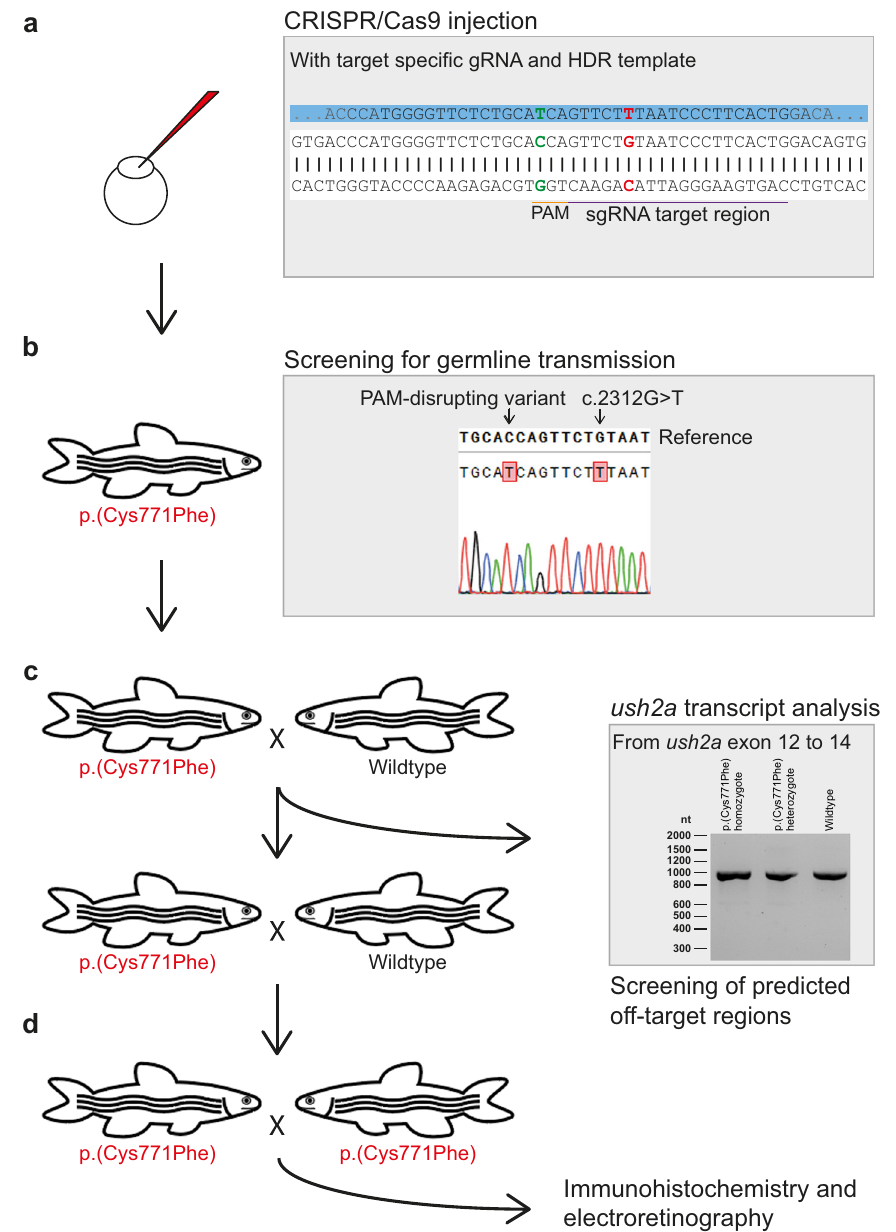
Fig. 2 Generation of the usherin p.(Cys771Phe) zebra fi sh model. a Eggs were injected at a one-cell stage with CRISPR/Cas9 mix containing both the target speci fi c single guide RNA (sgRNA) and the 126 nt homology directed repair (HDR) template (partially depicted, in blue) for incorporation of the c.2312 G > T (p.(Cys771Phe)) variant (in red) and protospacer-adjacent motif (PAM, in orange) disrupting variant (c.2304C > T, in green). The sgRNA target region is depicted in purple. b Once zebra fi sh were at reproductive age, eggs of the initially injected zebra fi sh were screened